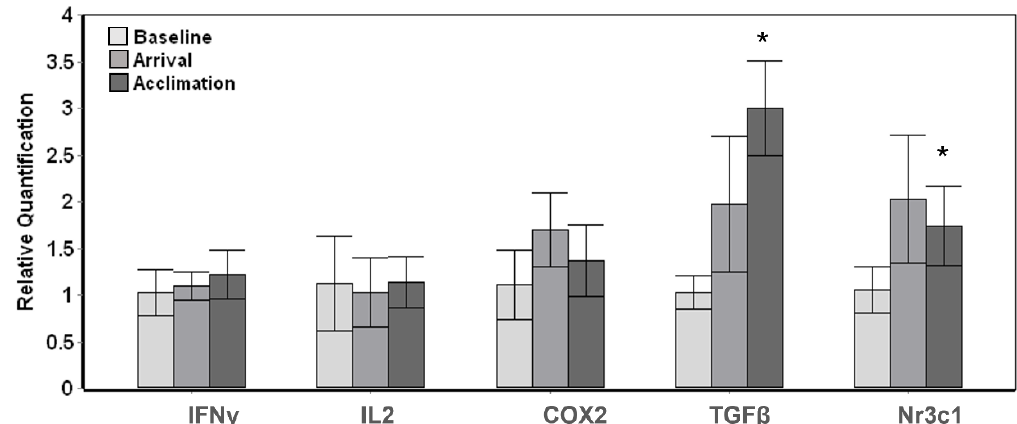
Figure 2. Gene expression changes in whales resident to Mystic Aquarium upon arrival of transported whales. The relative quantification values were obtained in relation to the average baseline expression (y = 1) for each gene. The pairwise significant differences between baseline and acclimation samples are indicated with a single asterisk (Posthoc pairwise test with Sidak correction, * p < 0.05). Error bars represent standard error of means for multiple individuals.